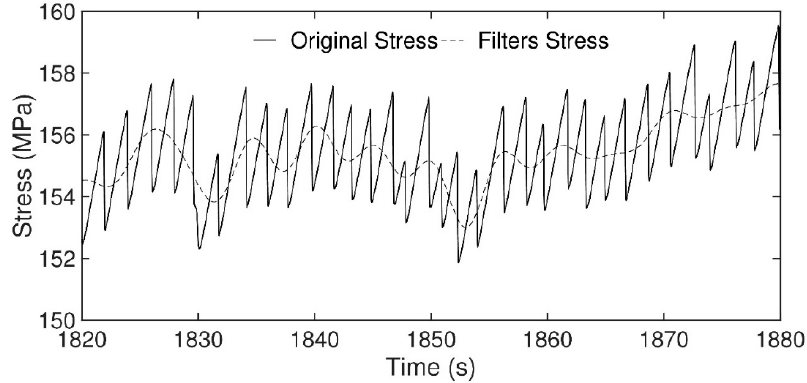
Figure 5. The original stress-time curve obtained from solution-treated Al–1 wt % Mg wires and the new filtered signal after conversion to its time domain.